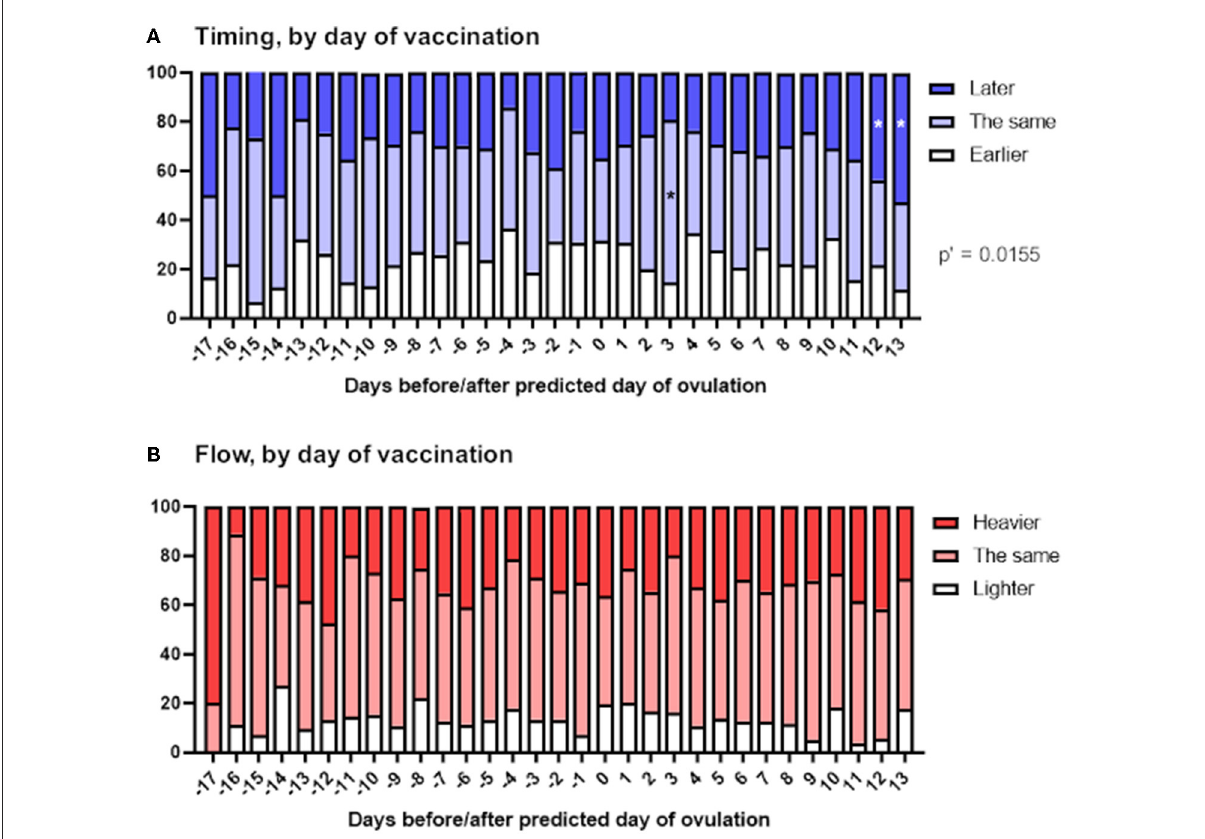
FIGURE4 Associations between menstrual changes and timing of vaccination within the menstrual cycle. The proportional area charts depict the proportion of respondents who reported a change to the timing (A) or flow (B) of the period following vaccination, stratified by day of the menstrual cycle on which the vaccine was given, relative to the predicted day of ovulation. Statistical testing with a Chi squared test with Holm-Bonferroni sequential correction for multiple hypothesis testing. Adjusted p -values are shown; * denotes categories in which the standardized residual is greater than the critical value